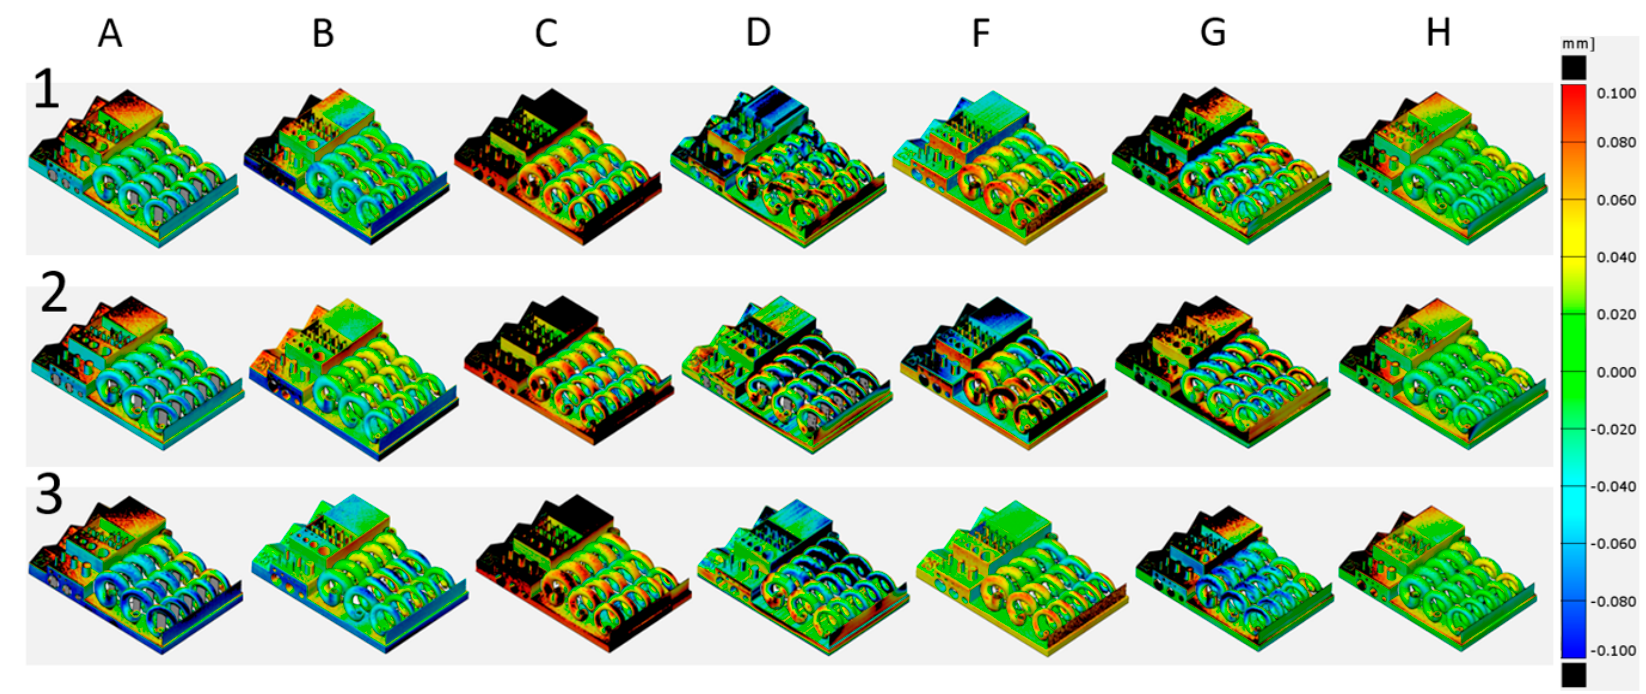
Figure 12. Comparison of color plots from the central sample of each benchmarking job. Job number is on the left (1, 2 and 3); letter on top represents participant (A, B, C, D, F, G and H); color scale is on the right.